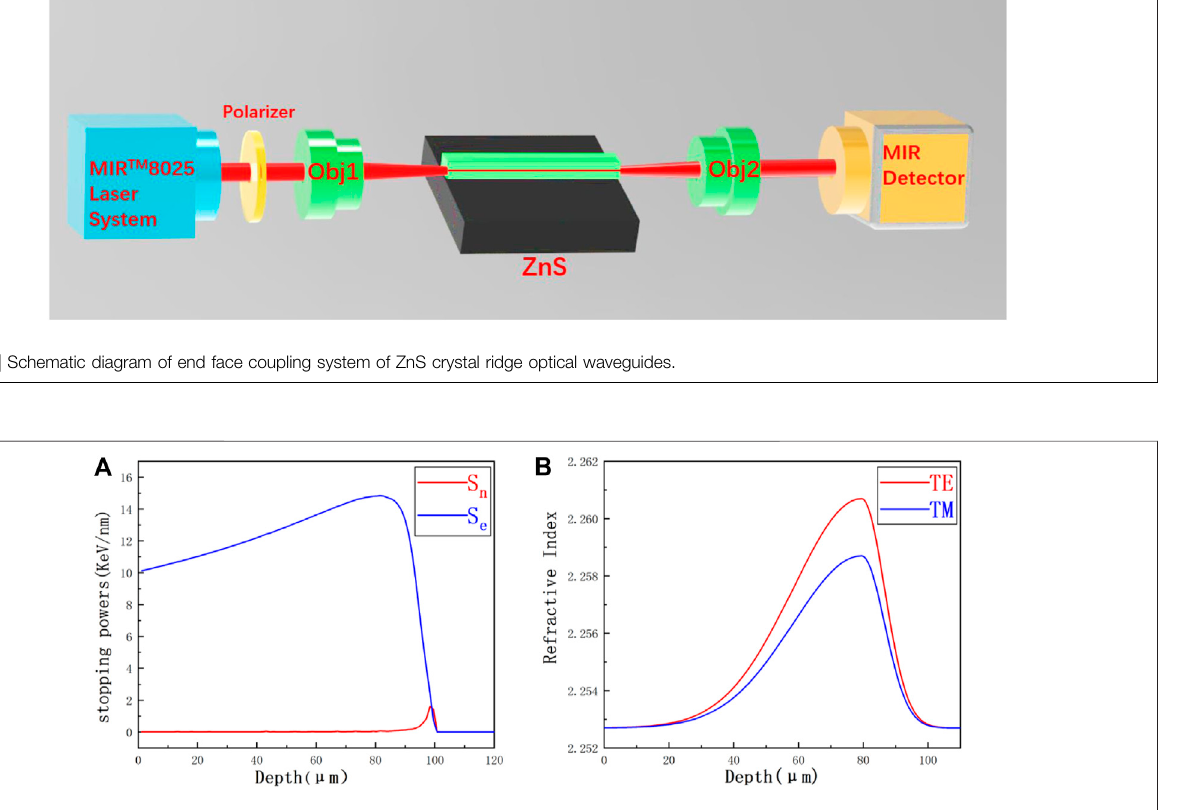
FIGURE 3 | (A) Electron (blue line, S e ) and nucleus (red line, S n ) stopping ability changes with the radiation depth of Kr 8+ ions; (B) Refractive index curves of ZnS ridge waveguide at 4 μ m wavelength in TM (blue line) and TE (red line)